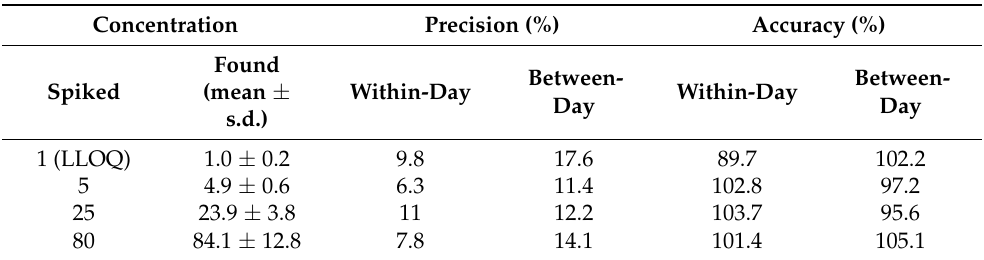
Table 3. Assessment of accuracy and precision. Data were from six replicates (5, 25, and 80 µ g/mL) and four replicates (1 µ g/mL) and analyzed on four different days.